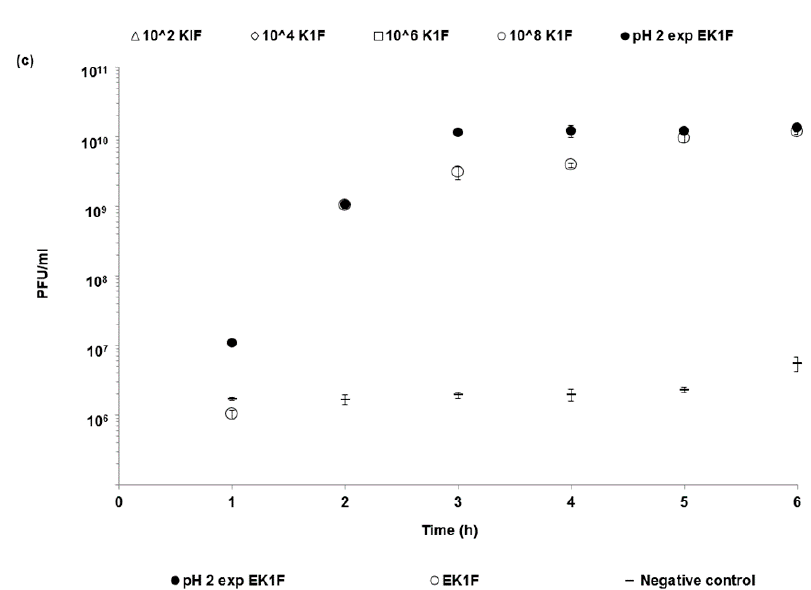
Figure 7. Dynamics of phage killing of E. coli strain EV36 bacteria with K1F bacteriophages: ( a ) Optical density curves showing bacteria killing in the presence of different concentrations of added phage, ( b ) phage amplification in the presence of E. coli strain EV36, and ( c ) comparison of the phage amplification of EK1F phages encapsulated in microparticles with and without exposure to SGF (2 h). Error bars represent one standard deviation.